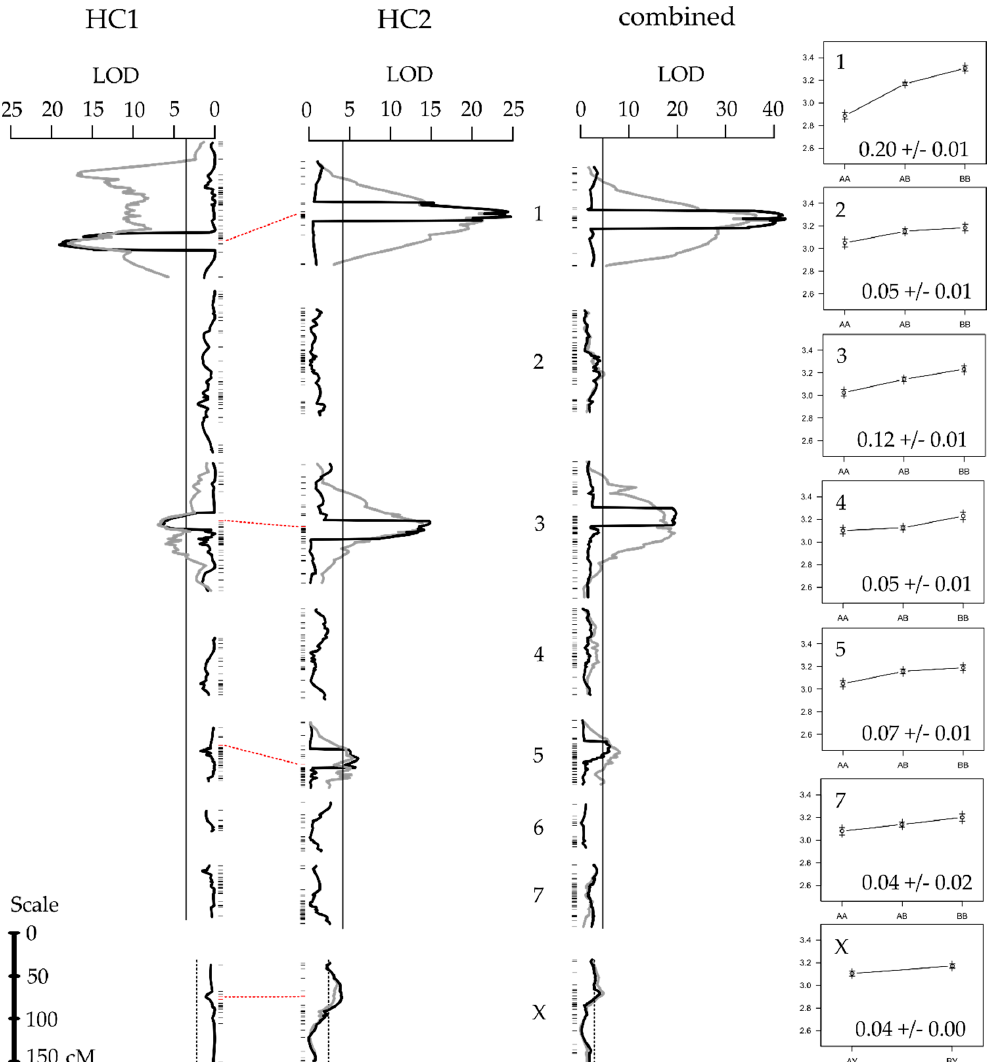
Figure 2. Quantitative trait locus (QTL) scan. Results from composite interval mapping (black lines) and multiple QTL models (grey lines, only for linkage groups with significant QTL). The vertical solid and dotted lines show the experiment-wide 5% significance threshold for the composite interval mapping (CIM) for autosomes and the X-chromosome, respectively. Between HC1 and HC2, the horizontal dotted lines connect the homologous markers associated with the QTL peaks (within the CIM windows) to indicate the overlap between the QTL scans in the different mapping families (see Figure S1 for more detail). The panels on the far right show the effect size of each of the QTL as the pulse rate mean ± standard error for each of the genotype categories AA (left), AB (center), and BB (right).